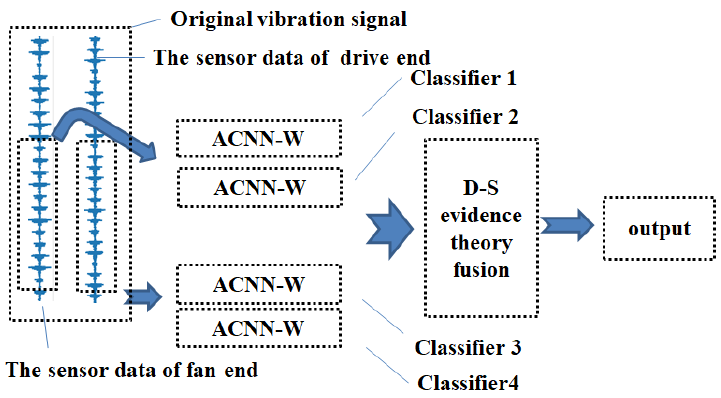
Figure 1. The framework of OFNN.